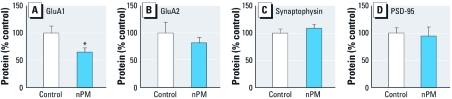
Chronic exposure of mice to nPM caused a decrease of GluA1 but no
change in GluA2, synaptophysin, or PSD95 in hippocampus in vivo, shown by
immunoblot analysis of whole hippocampal lysates of nPM- and control air-exposed
mice. (A) GluA1 levels were reduced 36% in hippocampal lysates from nPM
versus control (n = 7 hippocampi per group). No significant changes were seen
in GluA2 (B) or presynaptic [synaptophysin (C)], or postsynaptic
[PSD95 (D)] marker proteins. *p = 0.04 by t-test.